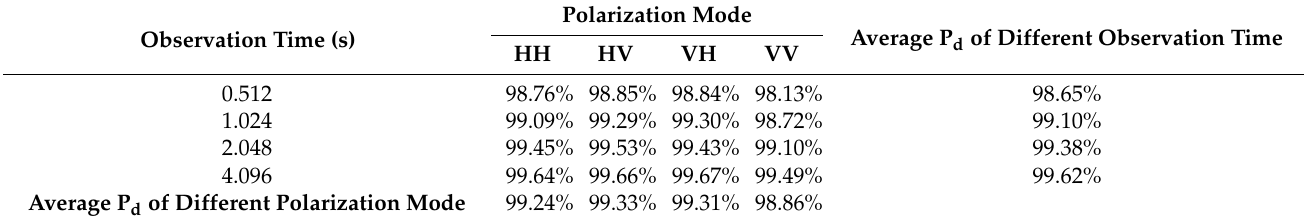
Table 11. Average detection probability of different